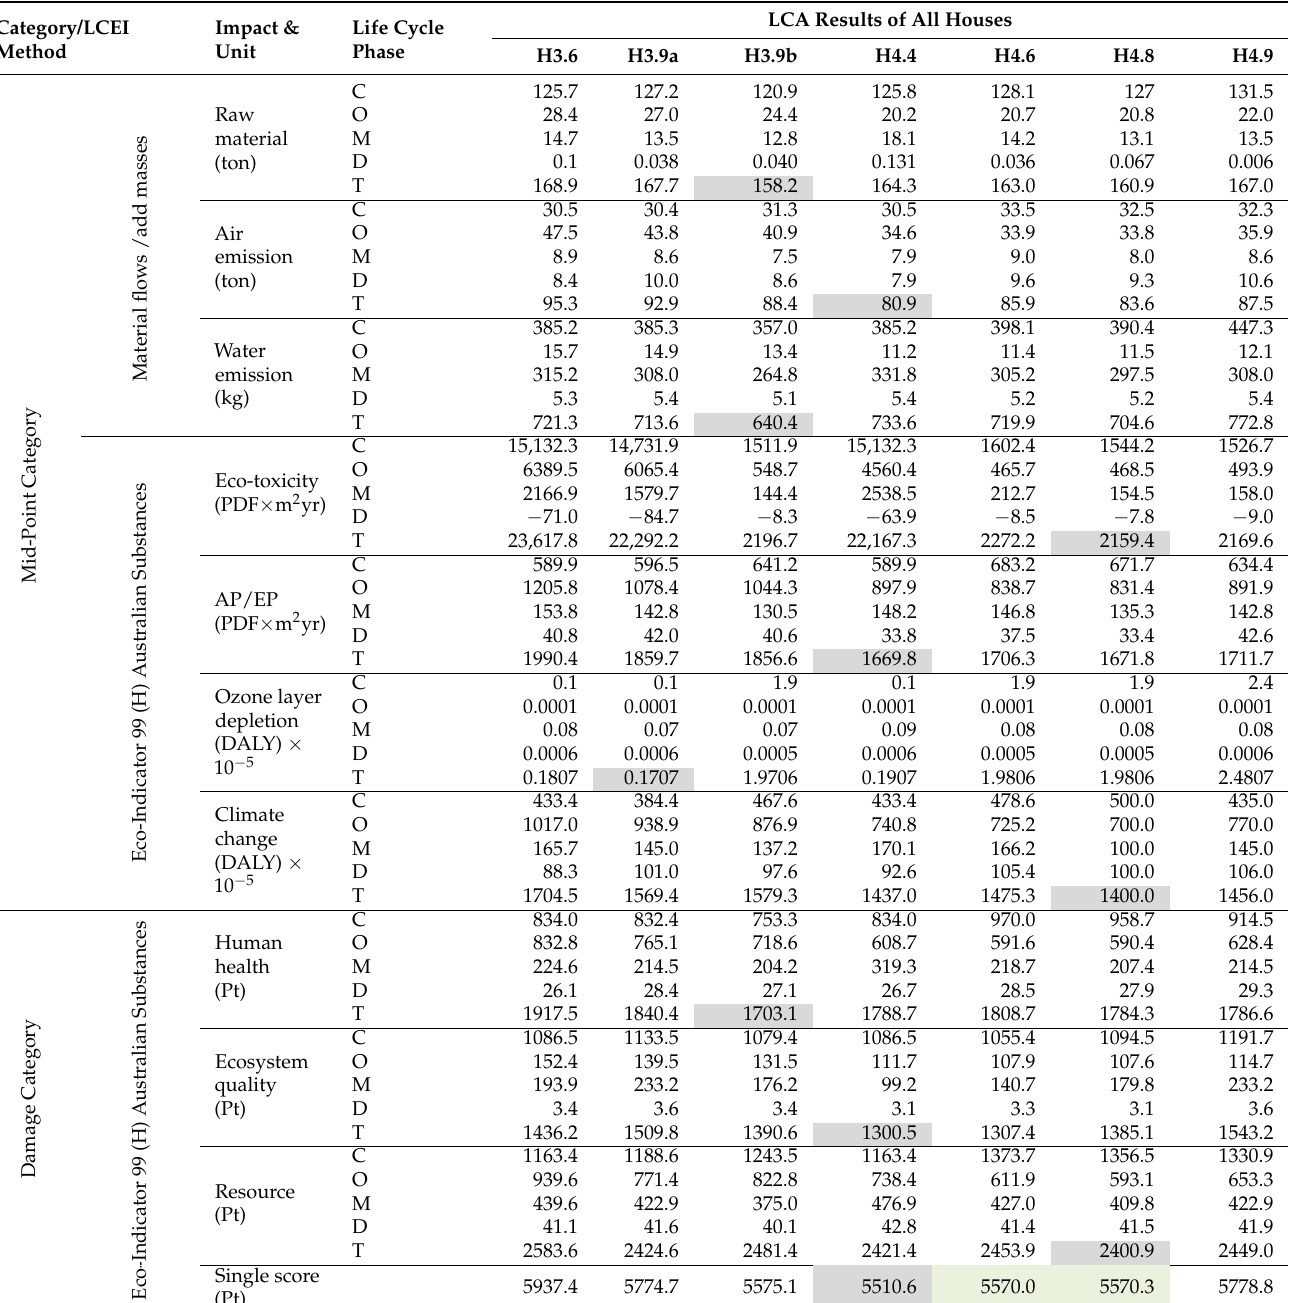
Table 8. LCA results for all the house